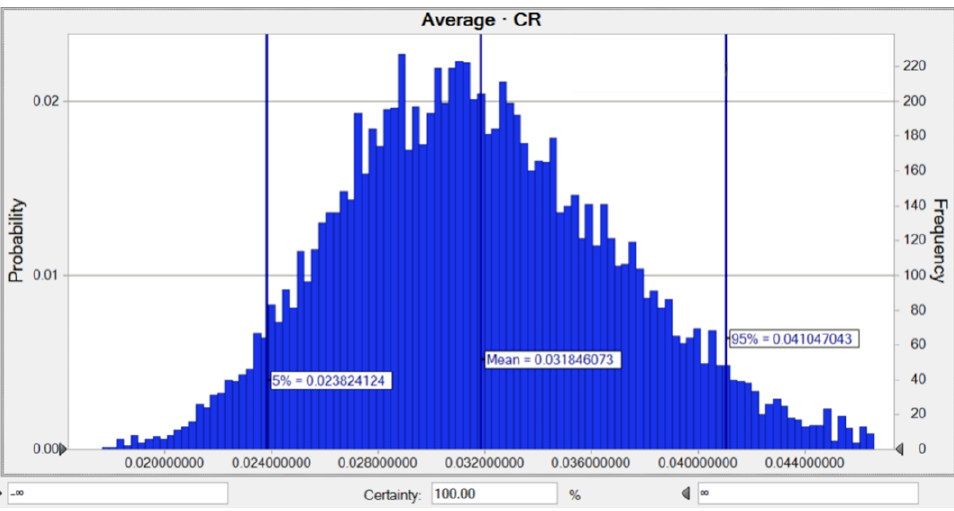
Figure 6. Predicted probability of TCR (adults) for As in water.